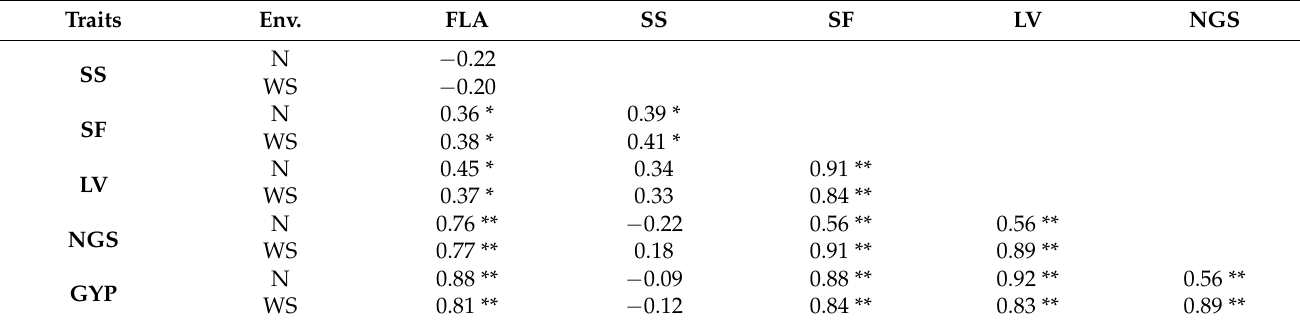
Table 3. Pearson’s Correlation coefficient of studied attributes based on data averaged over years under normal and water shortage environments. Traits Env.